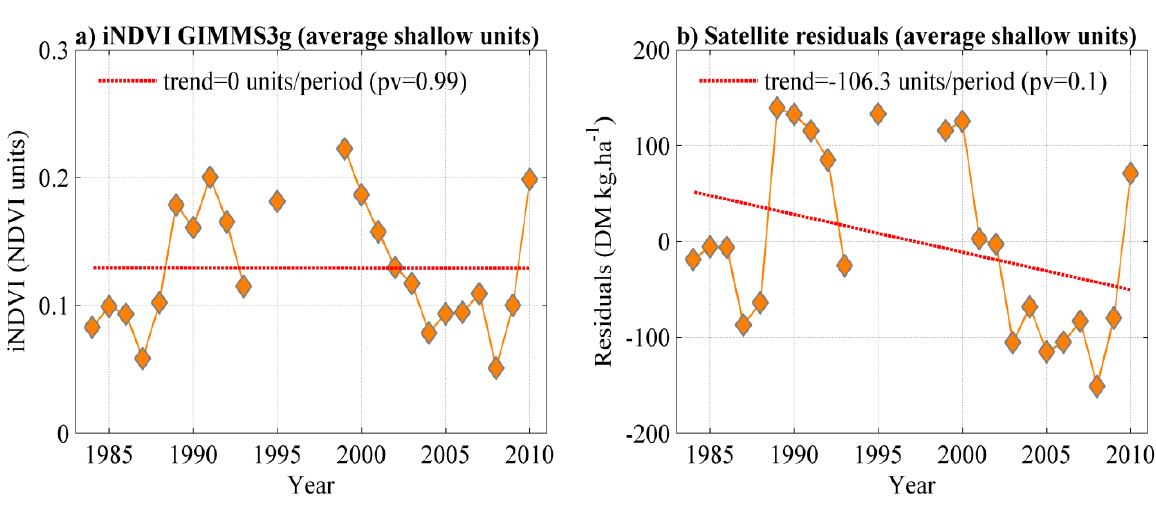
Figure 9. ( a ) GIMMS-3g iNDVI and ( b ) satellite residuals over the shallow soil unit (Sh and Sh ) described on Figure 1. Satellite residuals are calculated using the mean 1 2 rainfall over the Gourma region. No trend is found for iNDVI, while the residuals